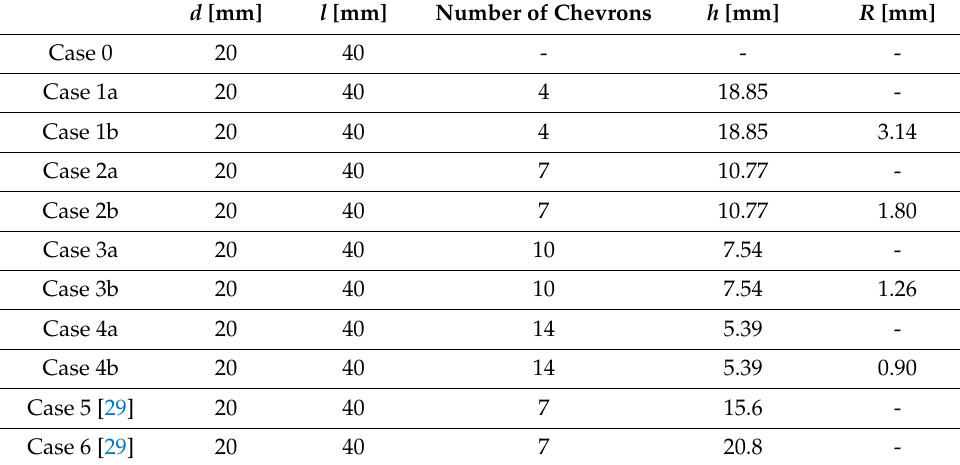
Figure 2. Schema of orifice. Table 1. Dimensions and parameters of SJA